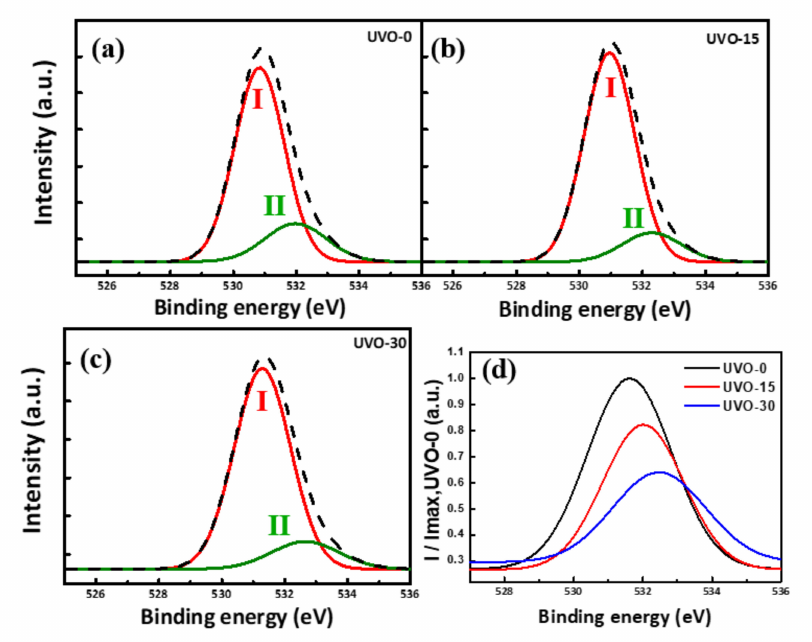
Figure 3. Normalized O 1s X-ray photoelectron spectroscopy (XPS) profiles of Ga 2 O 3 films: ( a ) non- treated, ( b ) 15 min, and ( c ) 30 min treated. ( d ) Comparison of the extracted O II spectra after UVO-0, UVO-15 and UVO-30 treatments with UV-light.